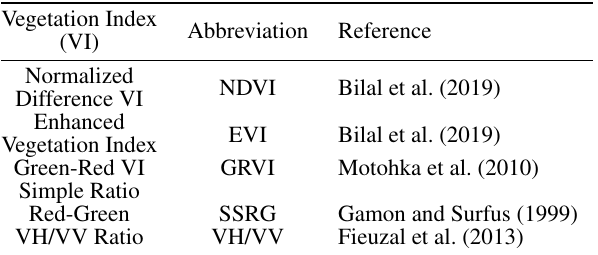
Table 3. Vegetation indices derived from optical and SAR